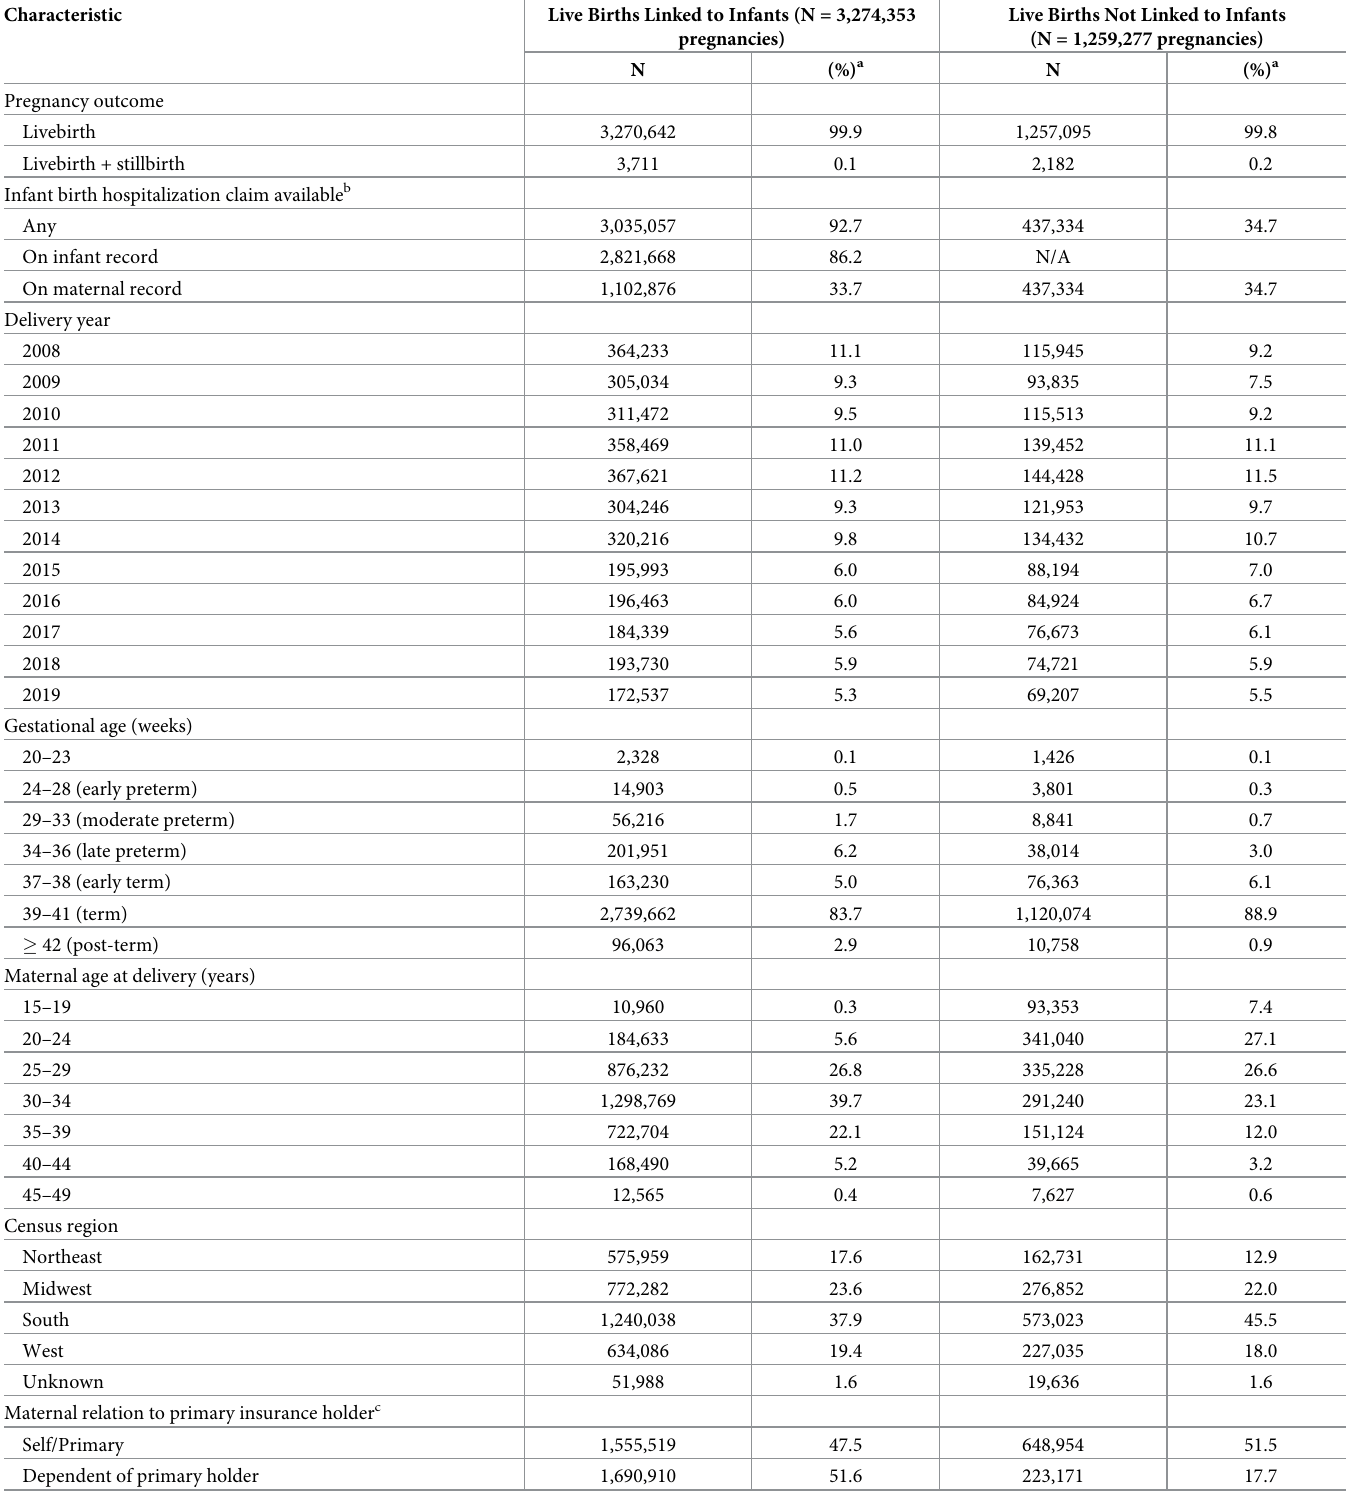
Table 3. Comparison of live birth pregnancies that linked and did not link to an infant record, Marketscan commercial data, 2008–2019 (N = 4,533,630). Characteristic Live Births Linked to Infants (N = 3,274,353